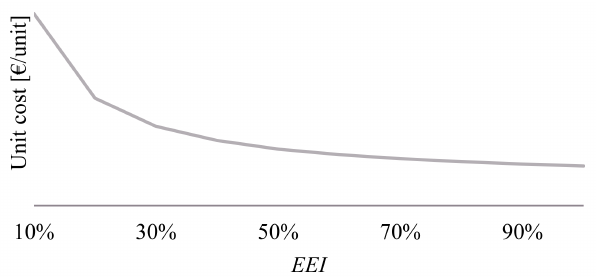
Figure 3. Influence of an increment of the energy efficiency index on the unit